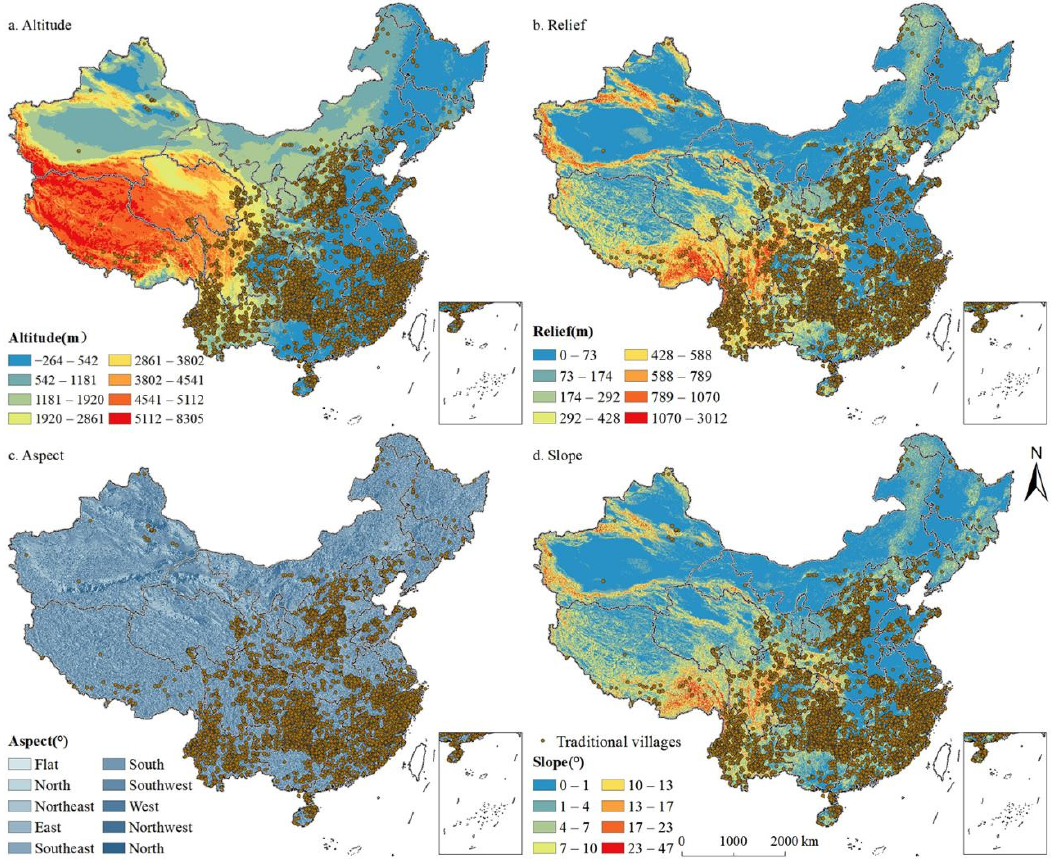
Figure 9. Spatial relationships between the distribution of traditional villages and natural geographi- cal factors.